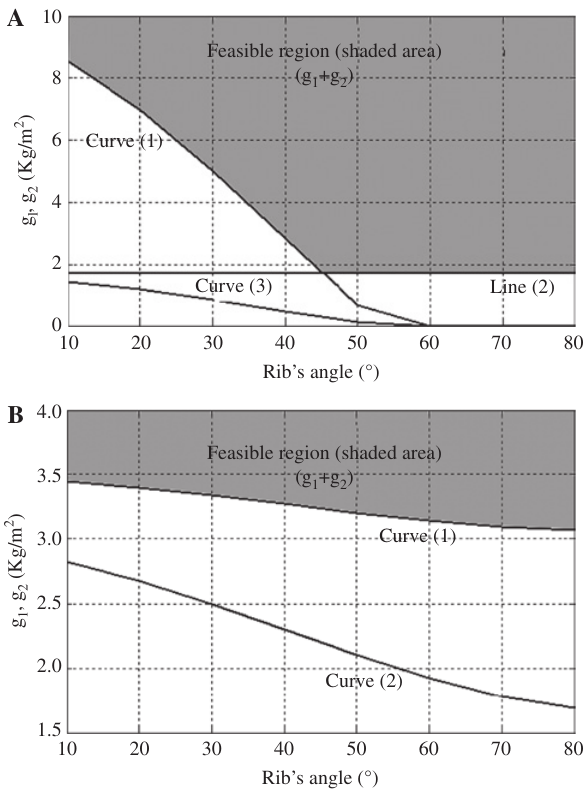
Figure 4 Feasible region of the vessel mass resulting from strain suppressing in (A) hoop direction and (B) axial